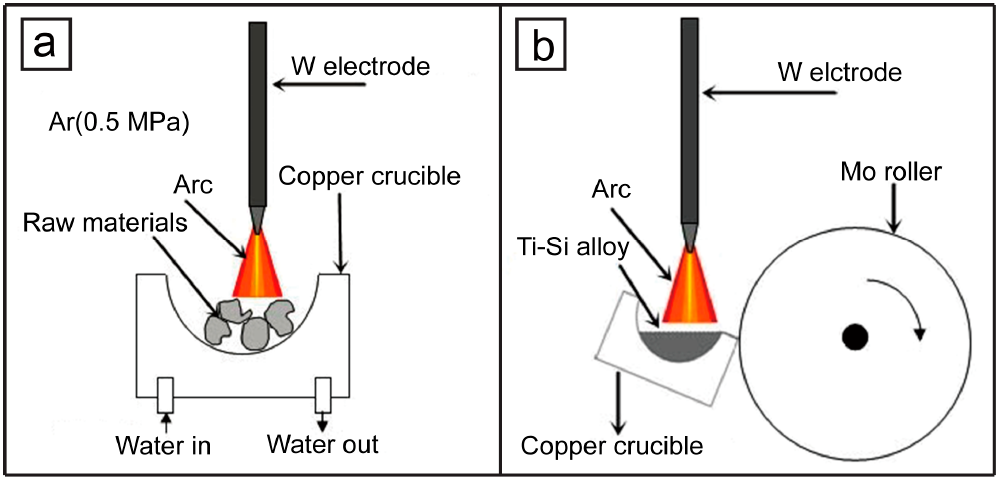
Figure 1. The schematic of experimental devices: ( a ) electric arc melting device; ( b ) melt-spinning device.